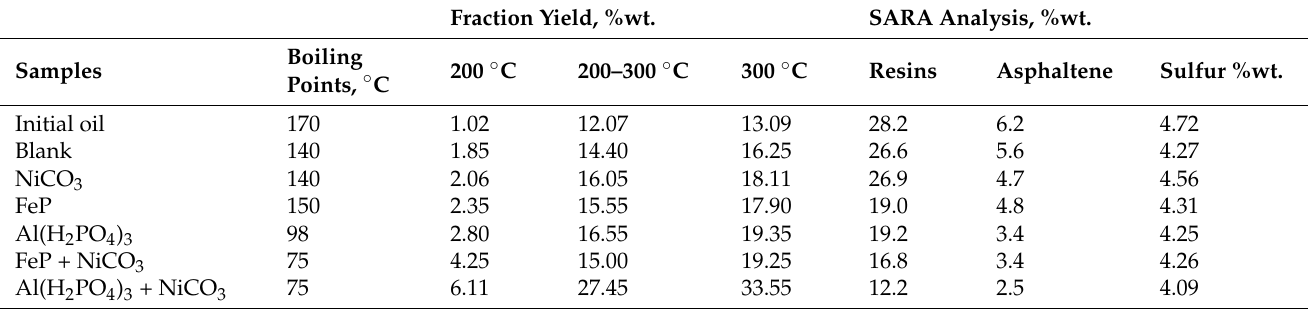
Table 1. Composition and properties of heavy oil before and after thermolysis. Fraction Yield,